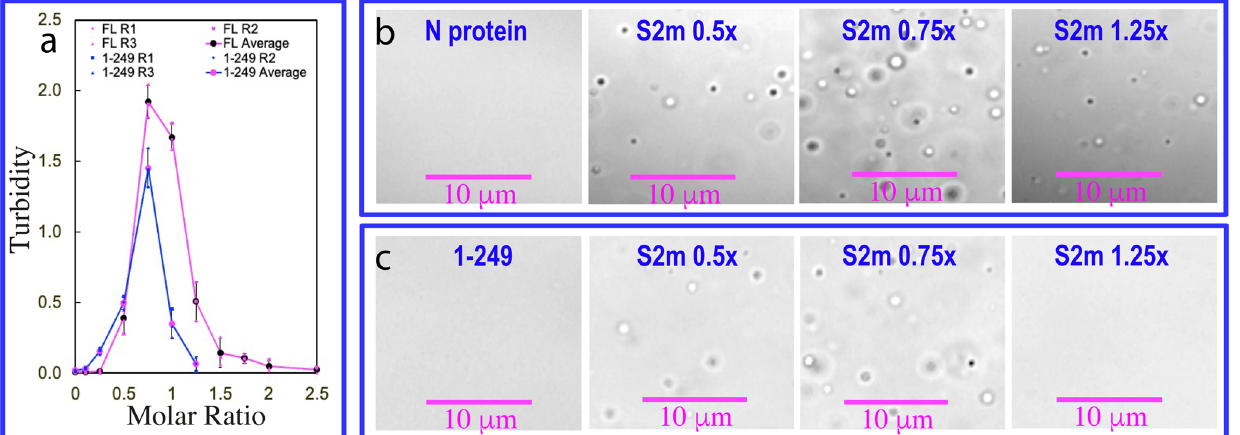
Fig. 3 S2m biphasically modulates LLPS of the full-length N and N (1-249) proteins. a Turbidity (absorption at 600nm) curves of the average values of three repeated measurements ( n = 3) with STD displayed as error bars of the full-length N and N (1-249) proteins in the presence of S2m at different ratios. b DIC images of the full-length N protein in the presence of S2m at different ratios. c DIC images of N (1-249) protein in the presence of S2m at different